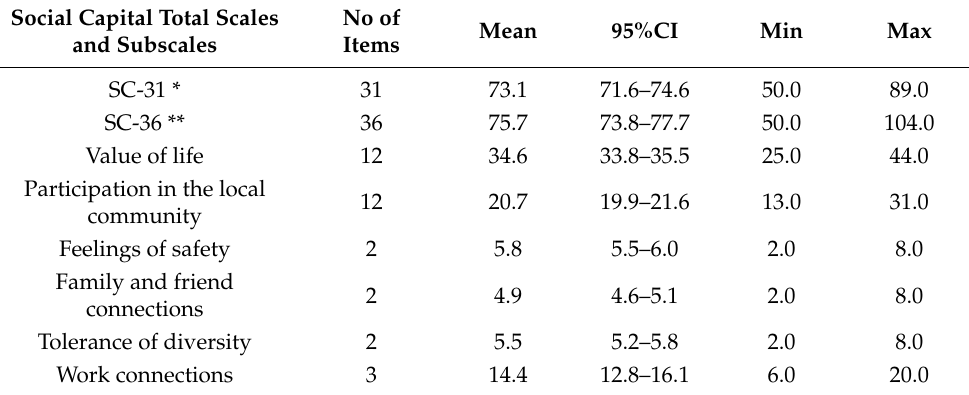
Table 3. Descriptive statistics of the social capital scales for the total